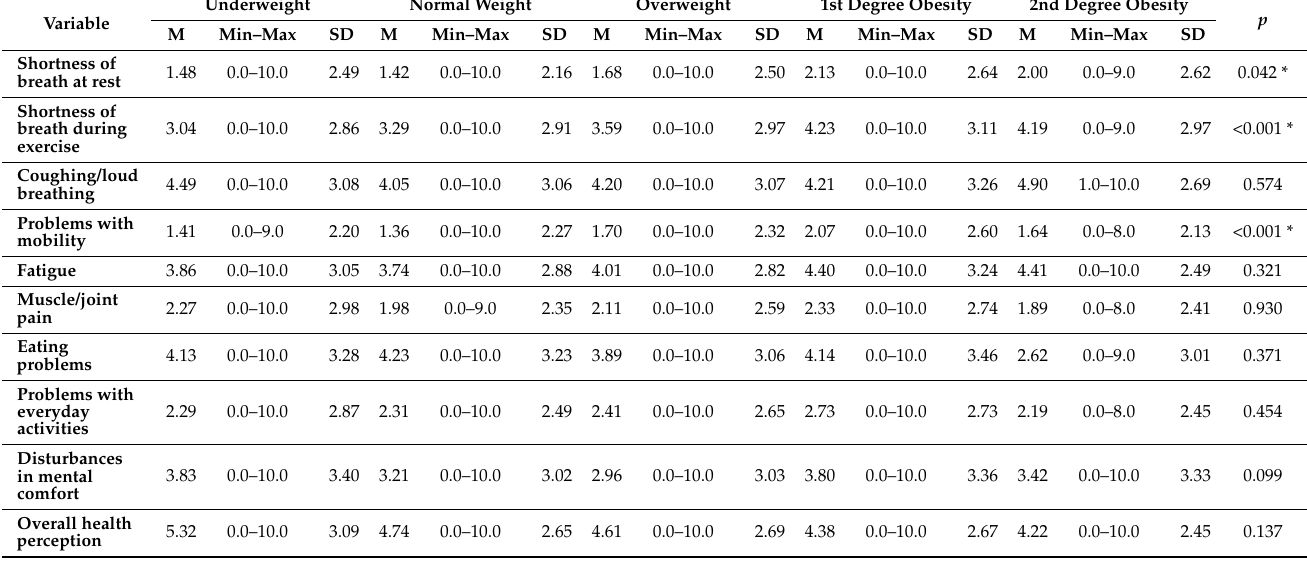
Table 3. Relationship between BMI levels and complications after COVID-19.